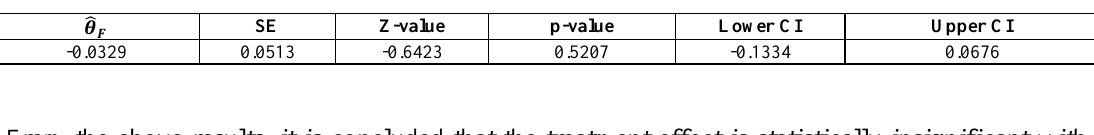
Table 7. Estimate for fixed effects model